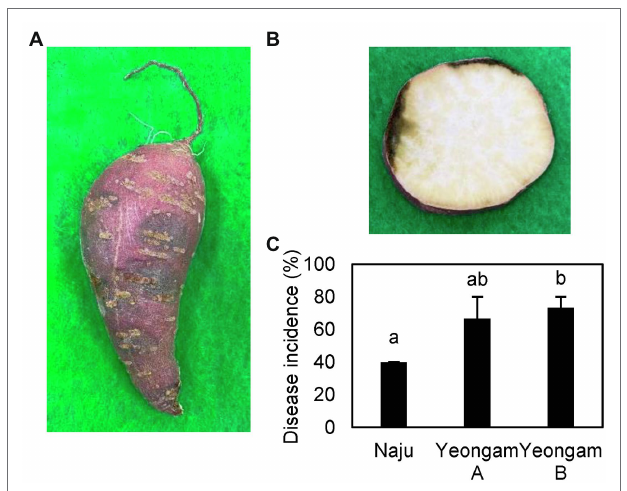
FIGURE 2 | Root rot incidence in the three fields—Naju, Yeongam A, and Yeongam B. (A) Lesion of tubers. (B) Cross-sectional lesion. (C) Severity of root rot of sweetpotatoes in the three regions. Incidence rate was investigated 3 months after storing sweetpotatoes (13 ° C, 90%). Data are expressed as mean ± S.E. ( n = 3, five biological replicates). Each value of different letters (a, b) above bars is significantly different by Duncan’s multiple range test at p <